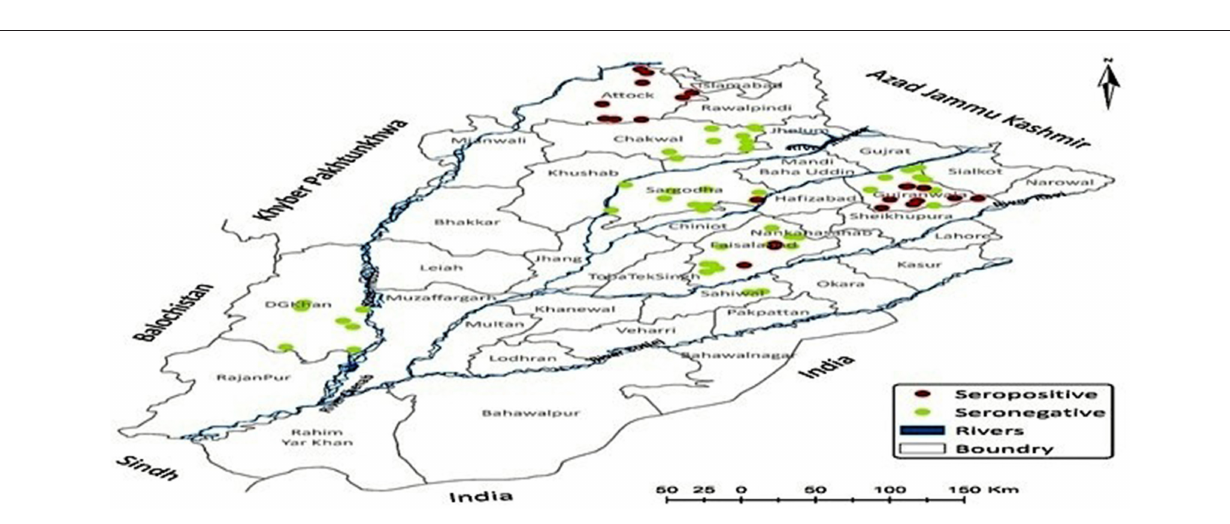
FIGURE 4 | Spatial distribution of anti-Francisella tularensis seropositivity in livestock originating from study